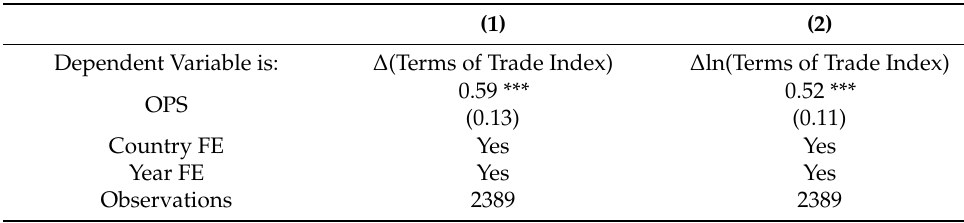
Table A1. Effects of OPS on the terms of trade.